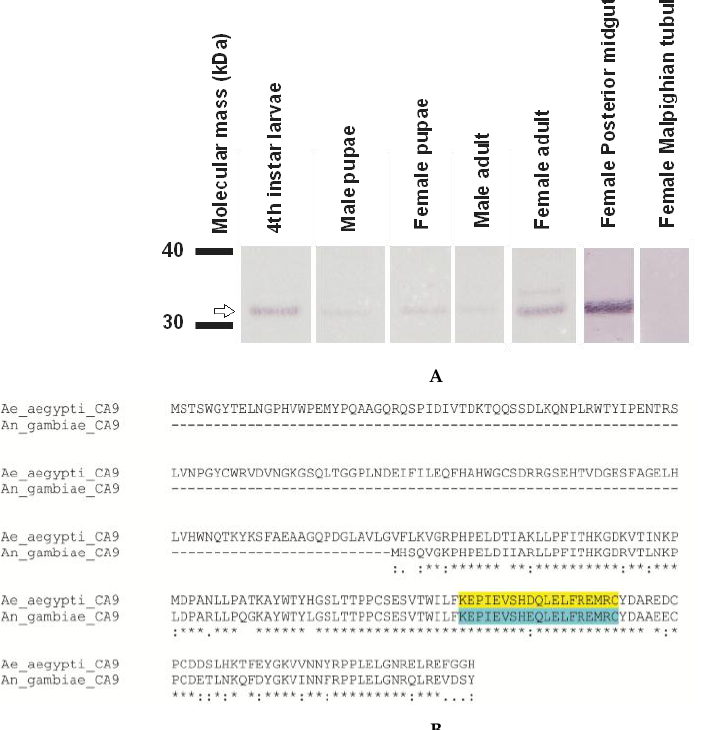
Figure 7. Western blot of AeCA9 in each life stage, female posterior midgut, and female Malpighian